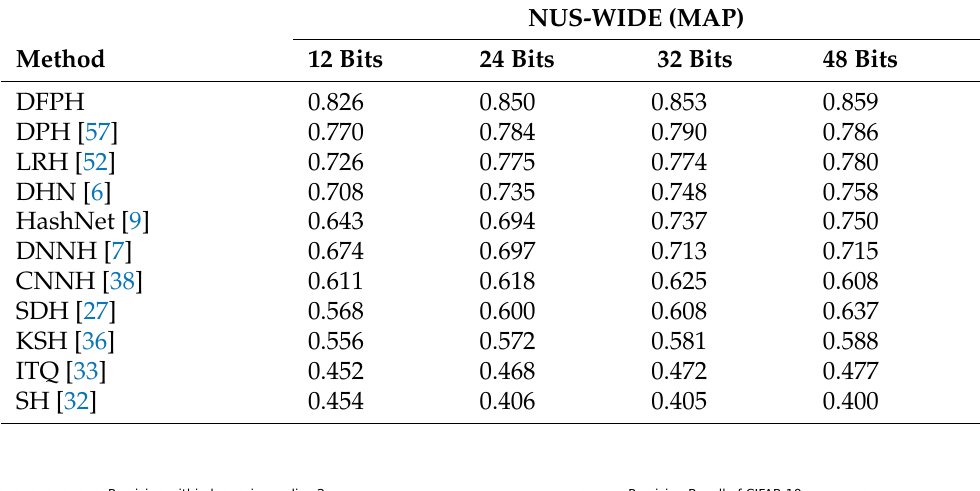
Table 3. The MAP of DFPH and other hashing methods on NUS-WIDE dataset, MAP are calculated within the top 5000 returned images.